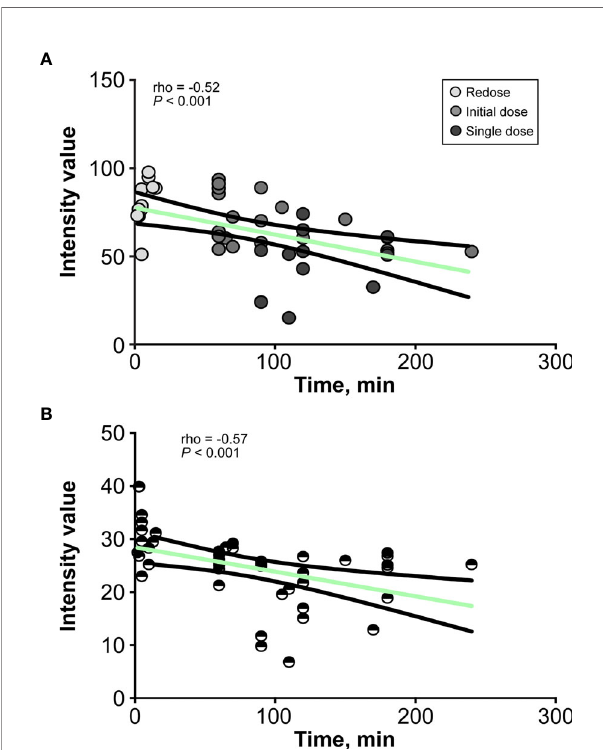
FIGURE 4 | Line graphs show the relationship between (A) the brightness and (B) the contrast of the confocal laser endomicroscopy image and the decay of fl uorescein sodium in minutes. The values are reported in units of optical density de fi ned by Fiji open-source analytic software. Brightness is the mean gray value, calculated by the sum of the gray values of all the pixels in the selection divided by the number of pixels, and contrast is the standard deviation of gray values used to generate the mean. Used with permission from Barrow Neurological Institute, Phoenix, Arizona. operative situations. All 7 reviewers demonstrated a higher percentage of accurate diagnoses in the analysis of redose imaging group versus initial-dose imaging group and single- dose imaging group; however, there was a signi fi cant increase in diagnostic accuracy across the 3 groups for the experienced neurosurgeons and neuropathologist ( Table 2 ). This fi nding